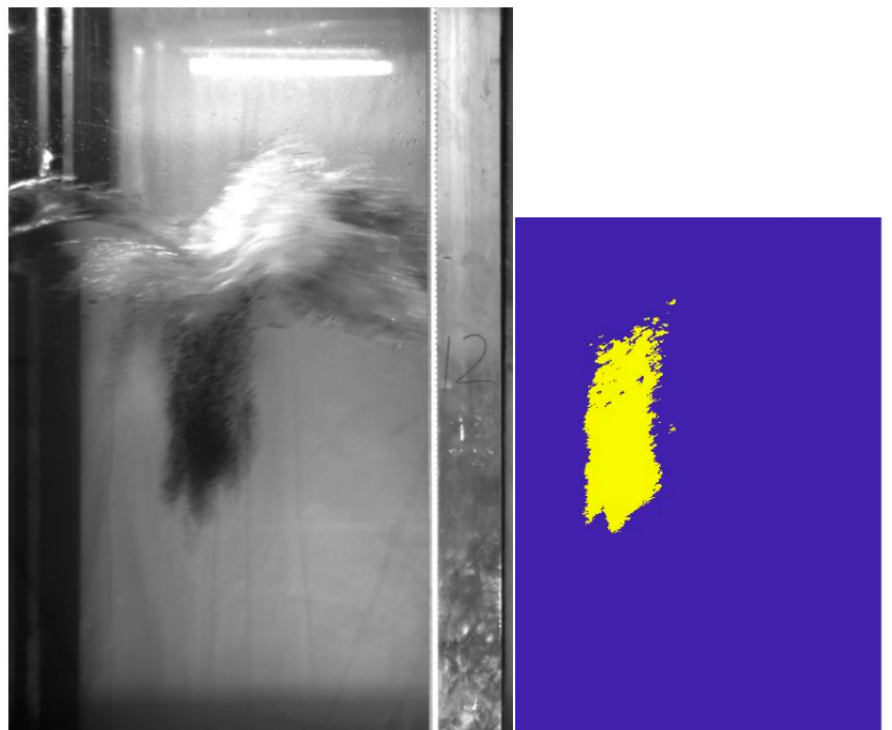
Figure 13. Spilled oil in the observation area was hit by 35 cm breaking wave.